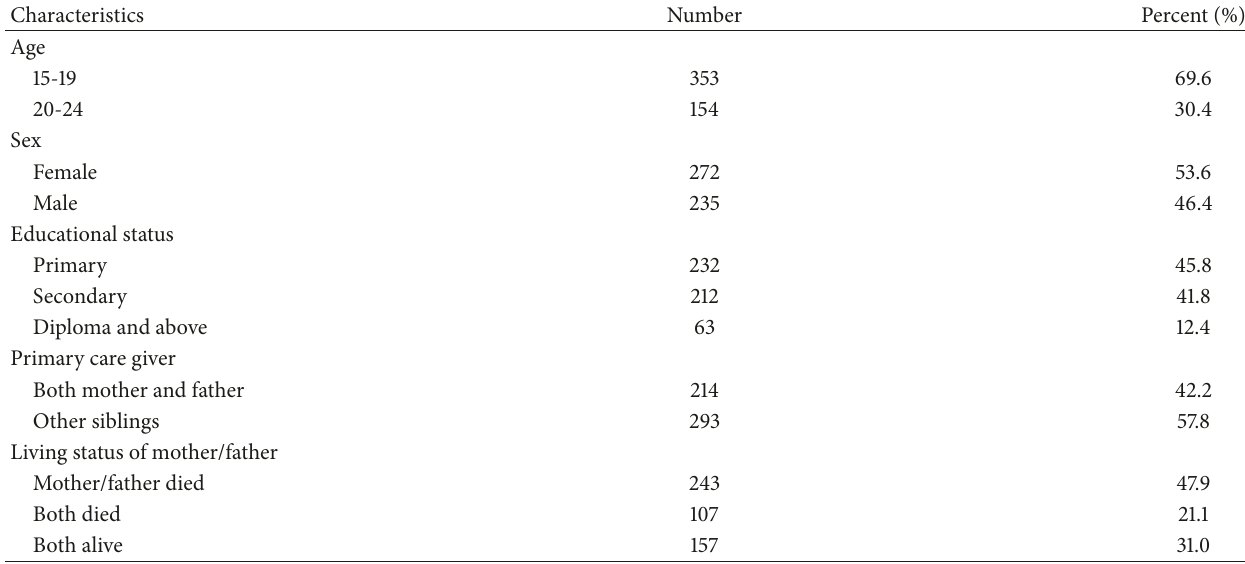
Table 1: Sociodemographic characteristics of HIV positive youth on ART follow-up at selected public hospitals in Addis Ababa, Ethiopia, 2016